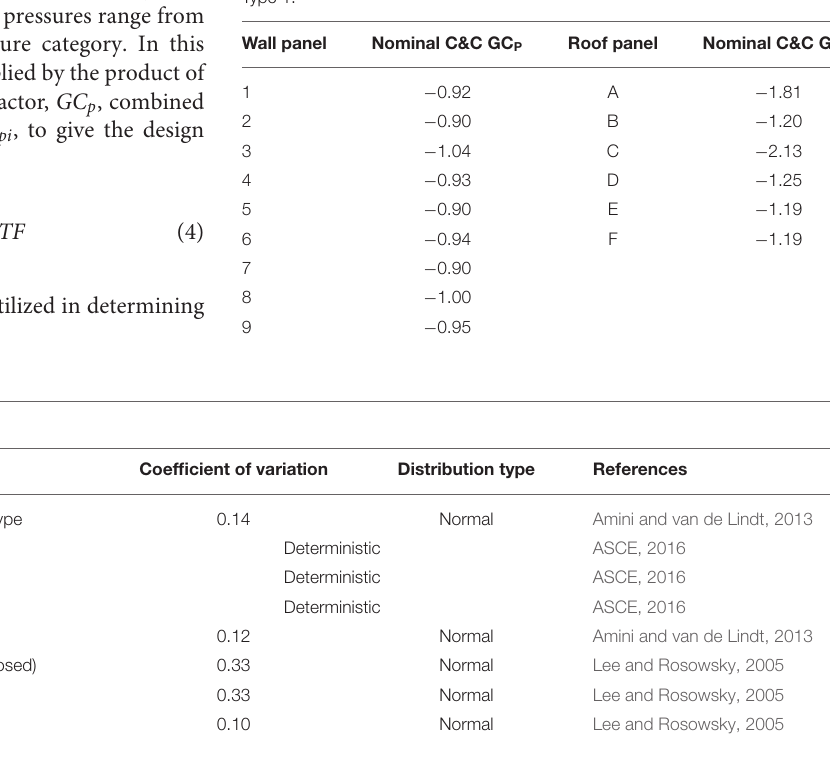
TABLE 4 | External pressure coefficients, GC P , used in wind analysis for structure Type 1.